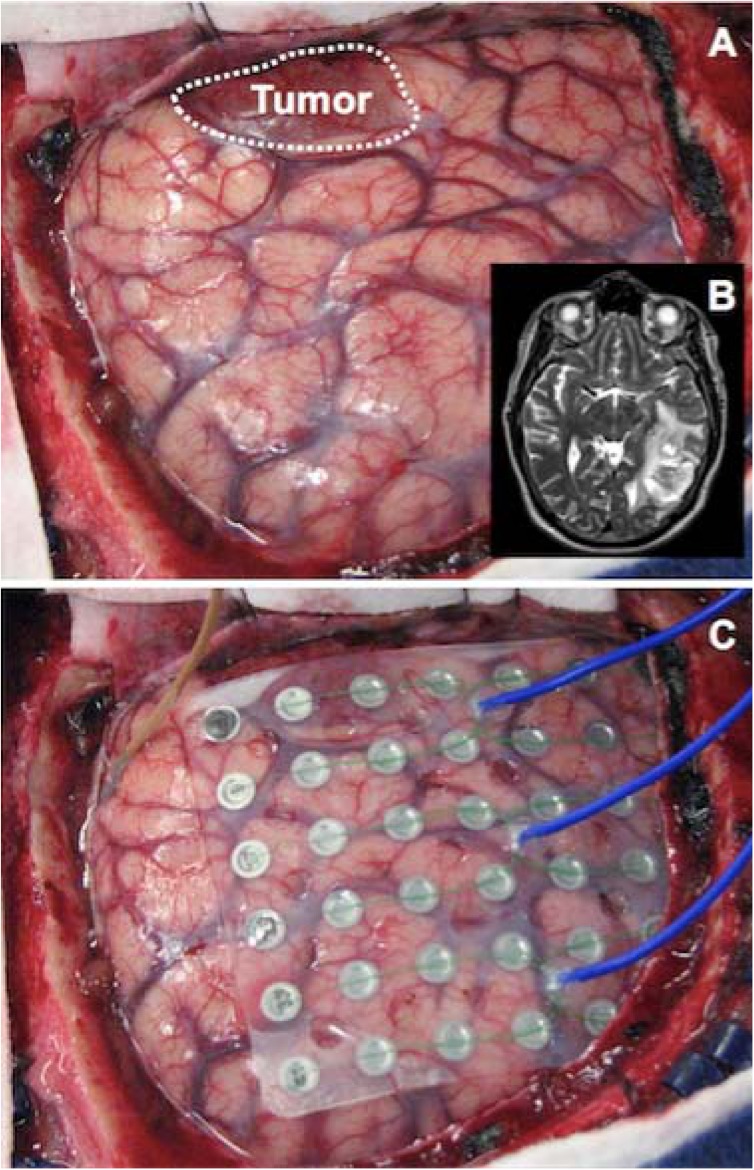
Intraoperative Photograph.(A) Exposed cortical surface demonstrating gross tumor. (B) Axial MRI slice from same patient identifying left temporo-occipital tumor. (C) Intraoperative ECoG grid on cortical surface for mapping.